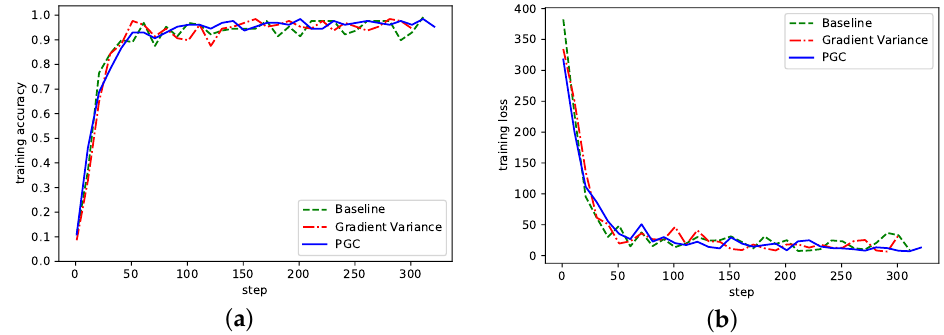
Figure 5. ( a ) Accuracy in ResNet network on MNIST; ( b ) Loss curve in ResNet network on MNIST. ResNet network adopted the ResNet-50 and MNIST datasets. Under the same experi- mental conditions, the accuracy of model recognition could reach more than 95% after only 300 steps of training. As can be seen from Figure 5, compared with the other two methods, the overall fluctuation of the adaptive compression algorithm based on gradient partition was more stable, and the accuracy rate gradually tended to a stable range, indicating that the algorithm could achieve normal convergence, and the loss curve also showed that the algorithm could achieve normal convergence. Similarly, training on the LeNet network could obtain similar results, as shown in Figure